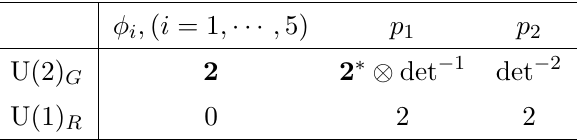
. S (cid:3) (cid:10)O (1) (cid:8)O (2)